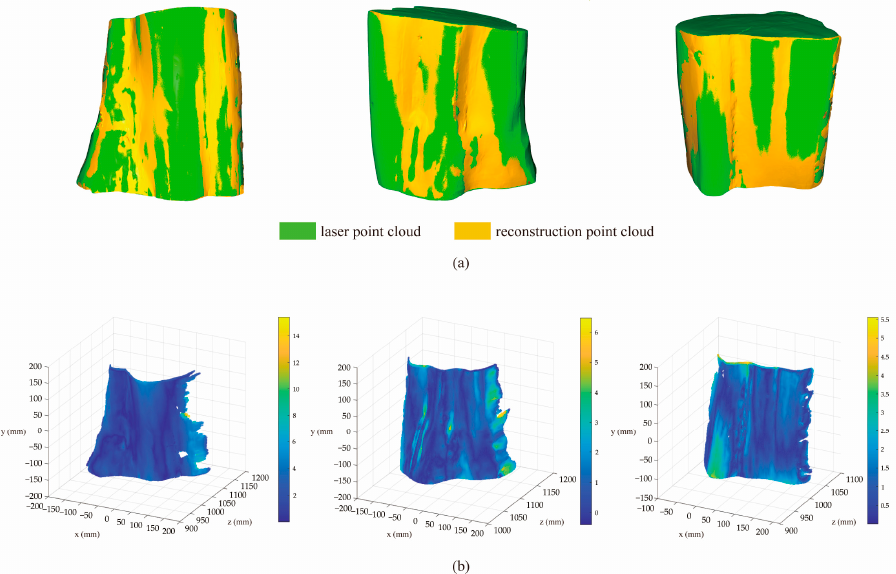
Table 4. Scale factor relative rotation and translation vector determined in the measurement.